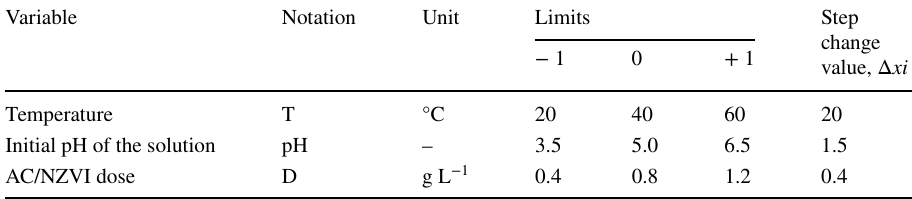
Table 1 Process variables, their coded values and